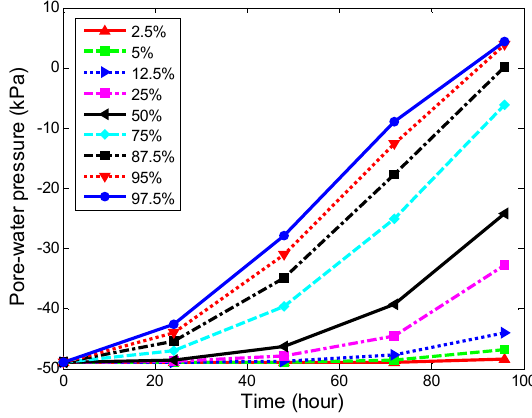
Figure 10. Pore-water pressure profiles at point M (25,15).